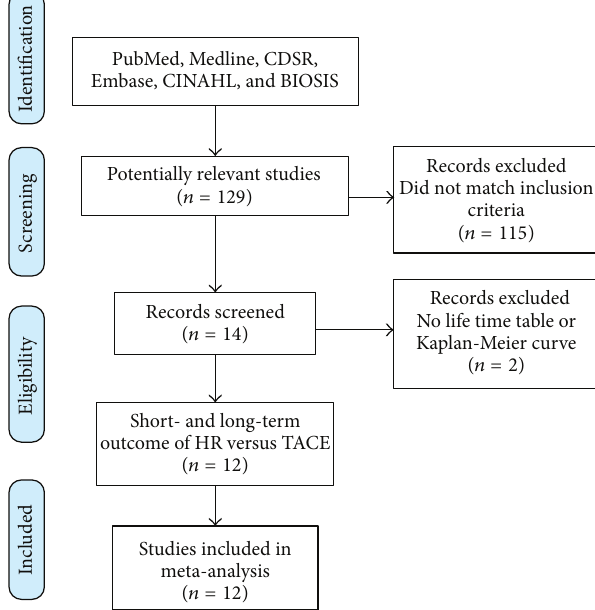
Figure 2: PRISMA flowchart diagram of search